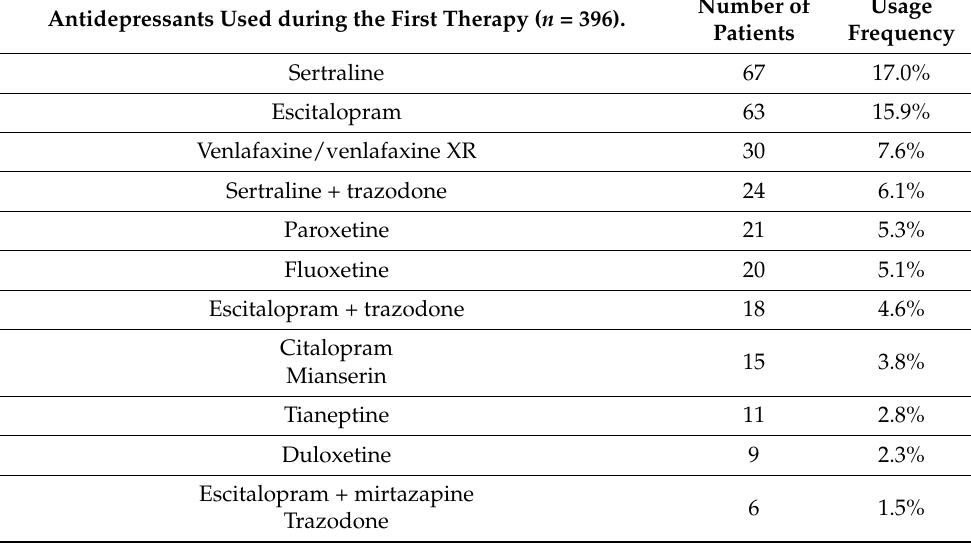
Table 5. Administered first-line antidepressant treatment during the current MDE (therapies with the same frequency of application are grouped together). Antidepressants Used during the First Therapy ( n =